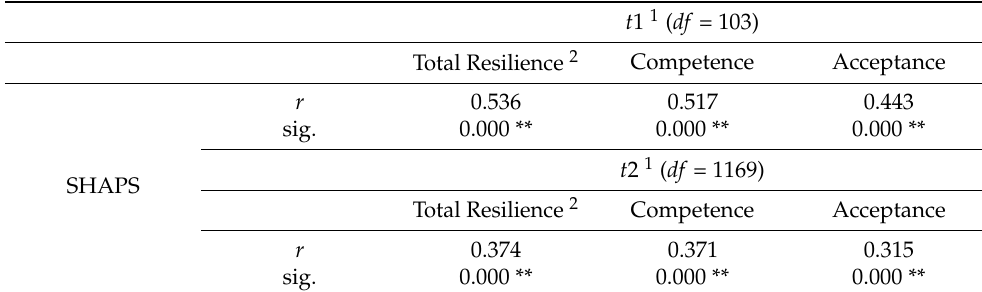
Table 3. Correlations of SHAPS with the resilience